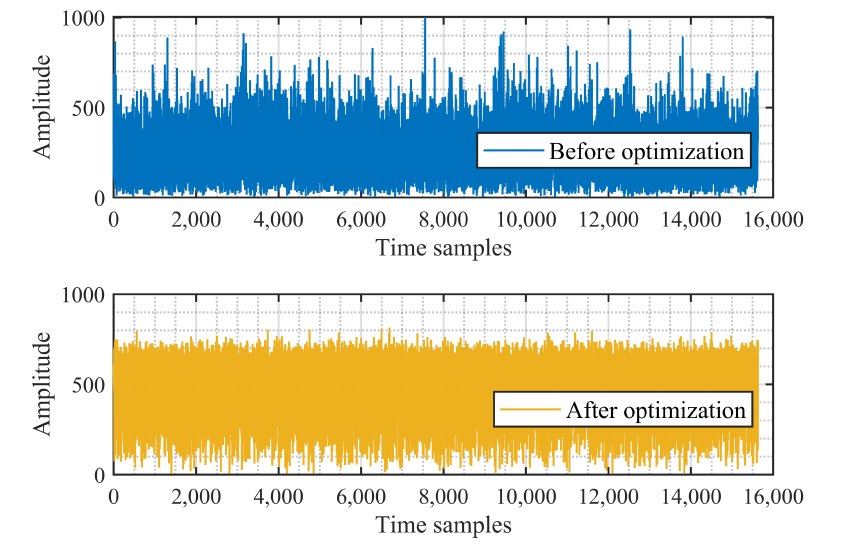
Figure 9. Echo waveform s for different OFDM symbols.